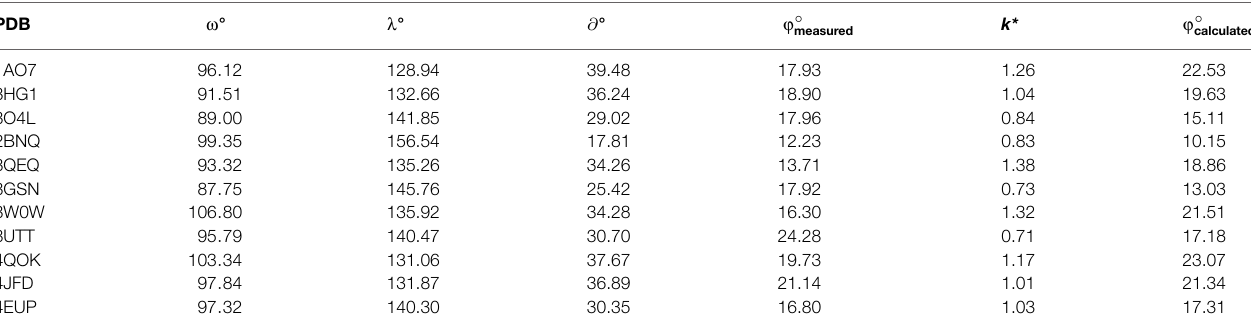
TABLE 1 | Predicting the R65-angle from the orientation of TCR-V α on pHLA-A